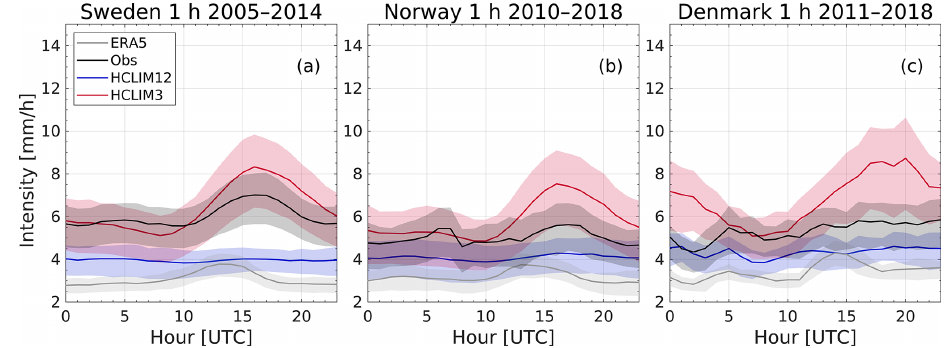
Figure 7. The mean diurnal cycles of the 99.9th percentile events for (a) Sweden, (b) Norway, and (c) Denmark. The shading presents the 25th and 75th percentiles from the spatial distribution. The label of Obs refers to the national high-resolution gridded datasets. The data are presented on their native